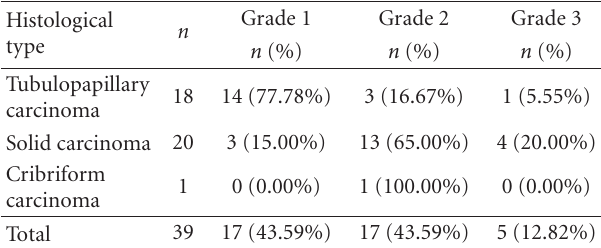
Table 2: Histological grade of the malignant epithelial